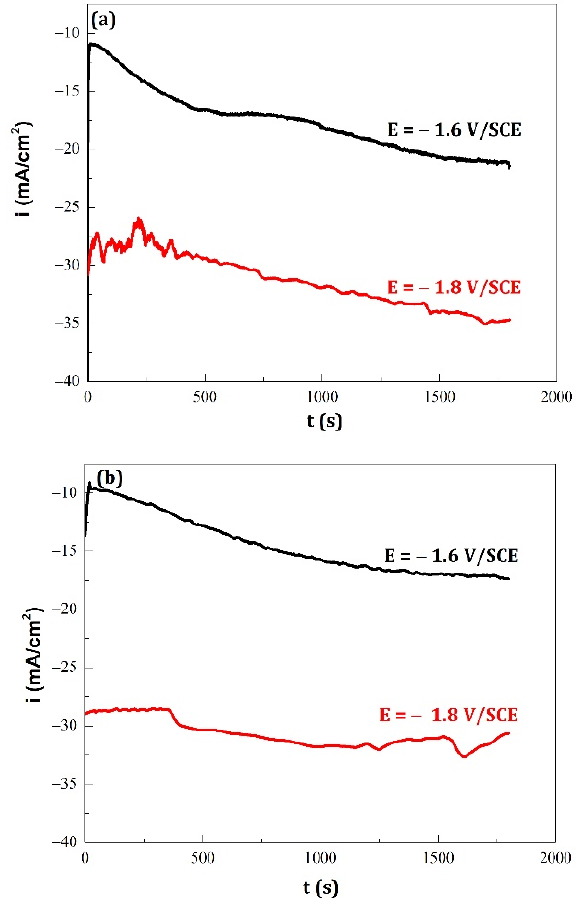
Figure 1. Current density (i) versus time (t) curves recorded during Zn–Mn alloy coatings electrode- posited as a function of magnetic field amplitudes: ( a ) B = 0 T, ( b ) B = 0.3 T and for two imposed potential E = − 1.6 V/SCE and E = − 1.8